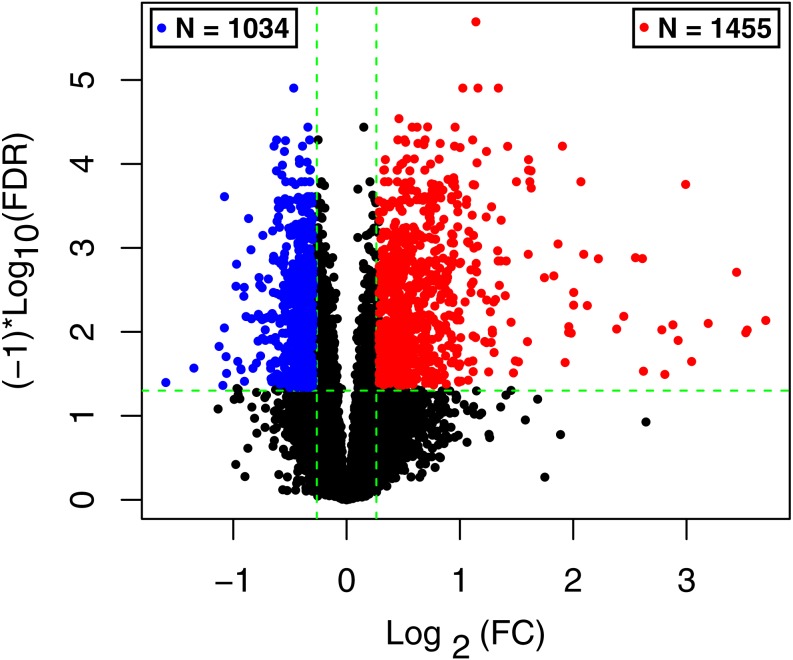
The volcano plot of the differentially expressed RNAs (DE-RNAs).The green horizontal dashed line represents false discovery rate (FDR) < 0.05, the two green vertical dashed lines represent—log fold change (FC)—> 0.263. The blue and red dots separately represent the significantly down-regulated and up-regulated RNAs in the samples in the acute phase of infection.